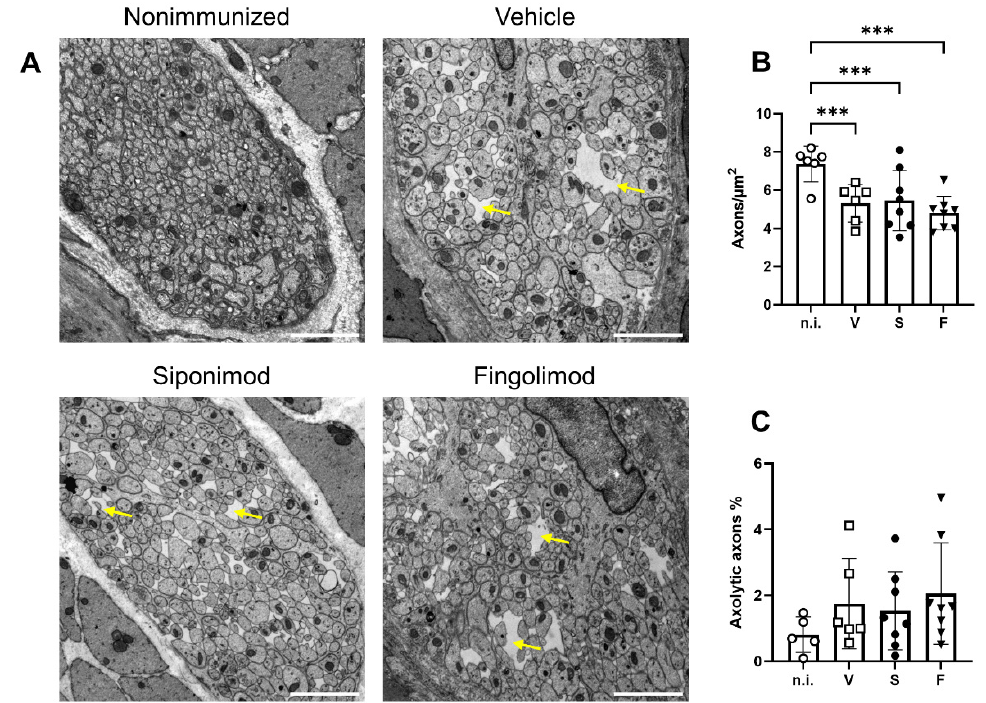
Figure 5. Analysis of the myenteric plexus in the colon of MP4-immunized mice using transmission electron microscopy. ( A ) Representative images of each treatment group in 10,000× magnification. Scale bars represent 2 µm. Yellow arrows indicate edematous gaps. ( B ) Quantification of the number of axons/µm 2 . ( C ) Quantification of the percentage of axolytic axons. Statistical analysis was performed using two-way ANOVA. *** p < 0.001. n.i. = nonimmunized, V = vehicle, S = siponimod, F = fingolimod, ANOVA = analysis of variance.